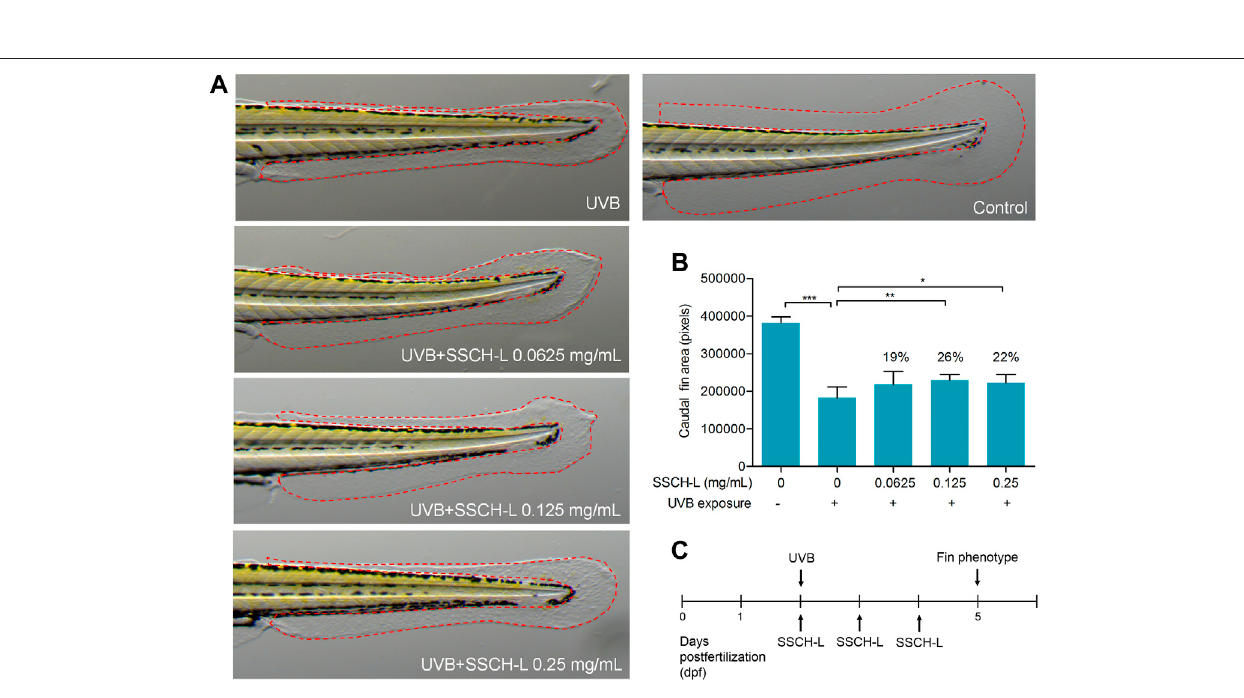
Frontiers in Bioengineering and Biotechnology |